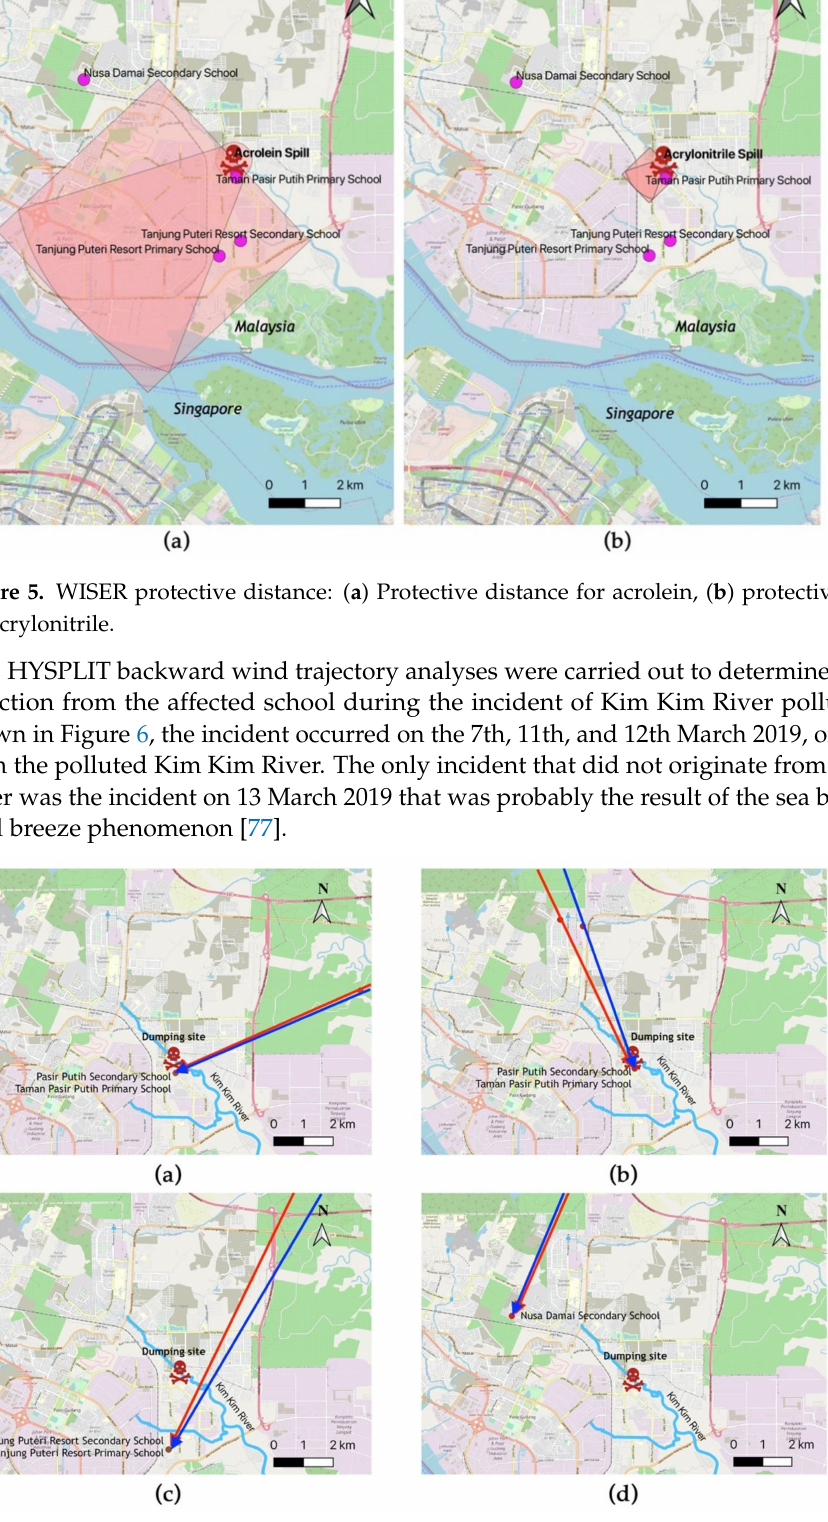
Figure 6. Hybrid Single-Particle Lagrangian Integrated Trajectory (HYSPLIT) model for backward trajectories to the affected schools during the incident of Kim Kim River pollution: ( a ) 7 March 2019; ( b ) 11 March 2019; ( c ) 12 March 2019; and ( d ) 13 June 2019. The red line is the trajectory at 50 m heights and the blue line is the trajectory at 100 m